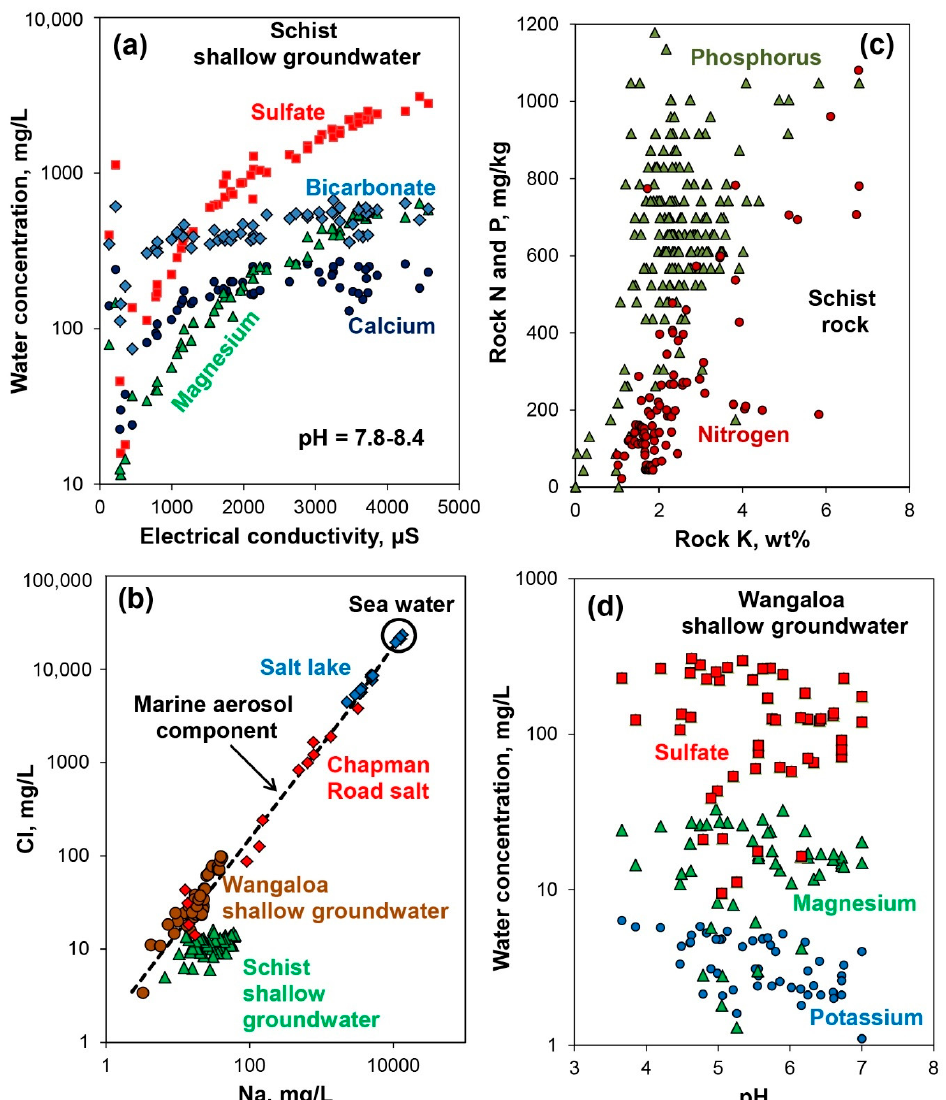
Figure 3. Contrasts between background schist-related environmental geochemistry, and the geochemistry of the historic mine sites outlined in this study. ( a ) Electrical conductivity and associated major ion concentrations in spring waters emanating from schist waste rock at Macraes gold mine (Figure 1a; 2b–d; Weightman et al. [30]). ( b ) Vegetation macronutrient contents of typical Otago Schist [34]. ( c ) Sodium and chloride concentrations in waters from two of the historic mine sites examined in this study, in relation to sea water and water in an inland evaporative salt lake (Figure 1a) [25]. Chapman Road data [27] indicate the dominance of NaCl salts, compared to the sulphate-rich schist shallow groundwater in a that yields mainly Ca-carbonate precipitates (Figure 2c,d). ( d ) Variations of pH and some shallow groundwater compositional data at Wangaloa coal mine [28].